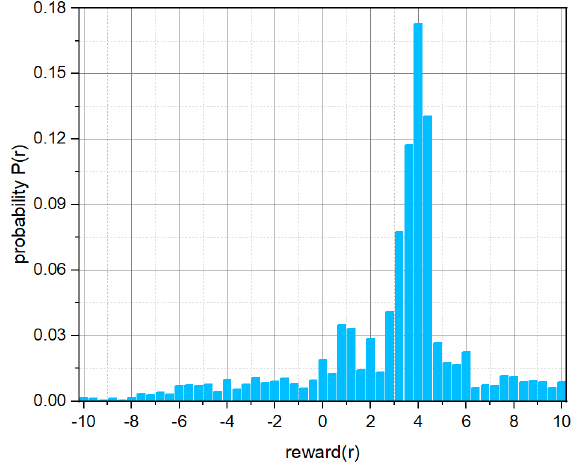
Figure 7. Example output of expected future earnings in the distributional DQN.